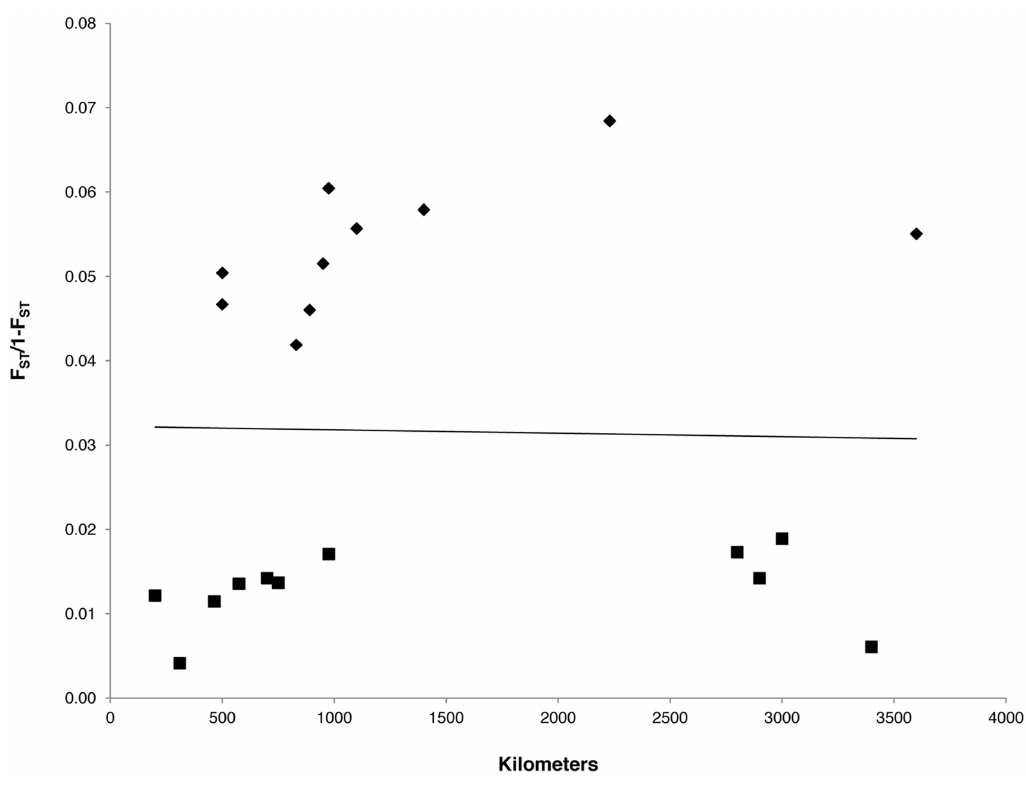
Figure 4. Large-scale genetic structure among sampling locations. A scatterplot of genetic distance versus geographic distance with a regression line showing the lack of a correlation between the two parameters ( P =0.30; Mantel test). Genetic distance was based on pairwise estimates of F ST /1- F ST among all seven sampling locations: Alberta (AB), Missoula (MSLA), Glacier (GL), Oregon (OR), Eastern Canada (EC), South Dakota (SD), and Idaho (ID). Geographic distances were calculated as the straight-line distance from the center of each sampling location. Pairwise estimates between locations within the boreal forest (AB, MSLA, GL, EC, ID) are represented with squares; pairwise estimates involving at least one location outside the boreal forest (OR, SD) are represented with